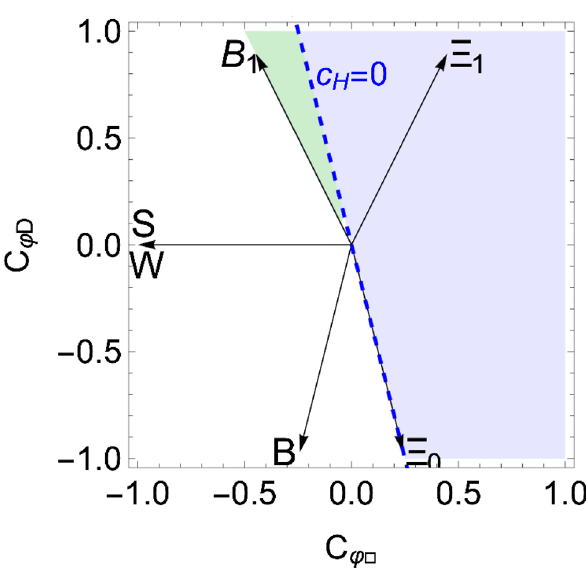
(cid:0) (cid:1) and its tree-level generators, normalized. The shaded C , C ϕD ϕ (cid:3) In this region, lower limits on g 2 Ξ 1 . = c + C 4 ≥ 0 H ϕD / ϕ (cid:3)